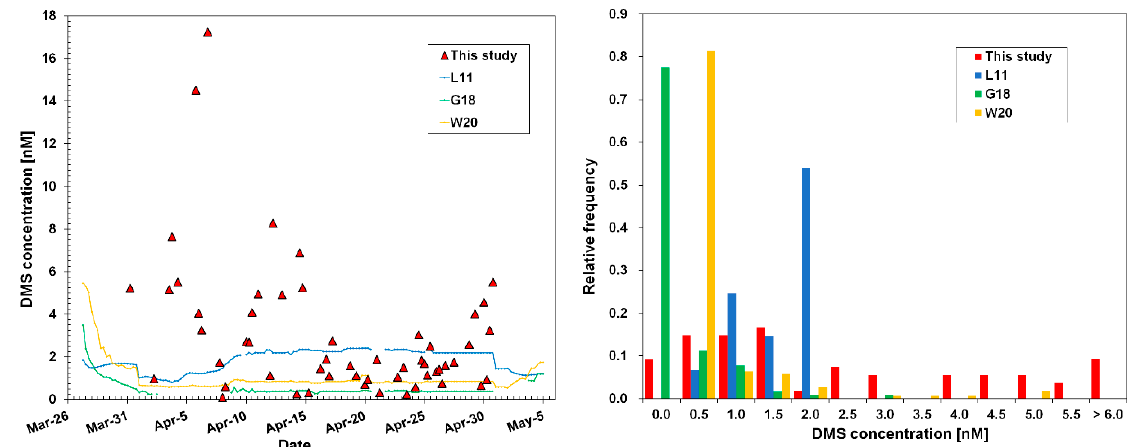
Figure 4. ( Left pane ) Comparisons of observed DMS concentrations (for 12 h average from this study, red triangles) with corresponding climatological seawater DMS concentrations estimated from three different emission inventories. Blue, green, and yellow dots denote the DMS inventories from Lana et al. [21], Gali et al. [22], and Wang et al. [23], respectively. ( Right pane ) Frequency distribution of DMS concentrations for the corresponding datasets in the left pane.